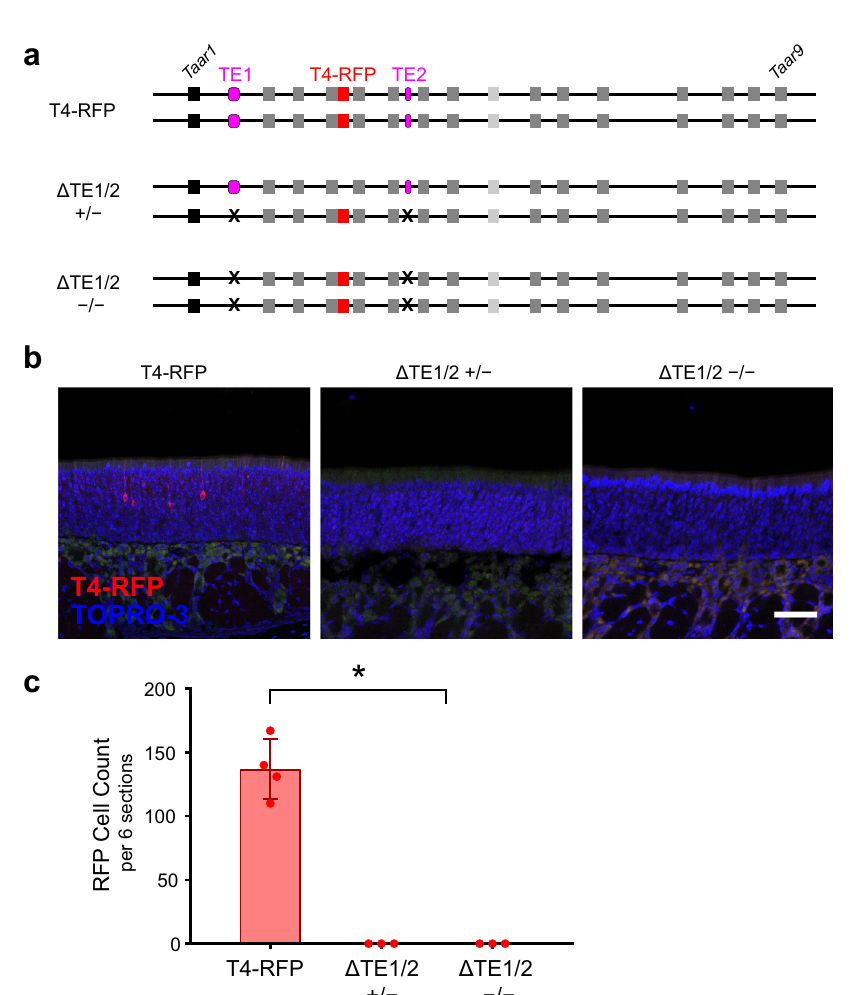
Fig. 7 TE1 and TE2 in fl uence TAAR gene expression in cis not trans . a Three genotypes used to test for trans effects of TAAR elements. TE1 and TE2 are shown (magenta). Deletions are indicated (X). Taar4-RFP targeted allele (red) is linked to the double deletion, Δ TE1/2. b Confocal images of representative olfactory epithelium sections showing RFP-labeled OSNs (red) in Taar4-RFP mice (left). Nuclei are labeled with TOPRO-3 (blue). No labeled OSNs are seen in homozygous (right) or heterozygous (middle) Δ TE1/2 mice ( n = 3 mice per genotype). c Average number of RFP + OSNs counted in 6 representative olfactory epithelium sections from Taar4-RFP ( n = 4), Δ TE1/2 heterozygous mice ( n = 3), and Δ TE1/2 homozygous mice ( n = 3 mice). * p < 0.0001 two-sided, ANOVA with contrasts. Error bars indicate mean ± SEM. Scale bar = 50 µ